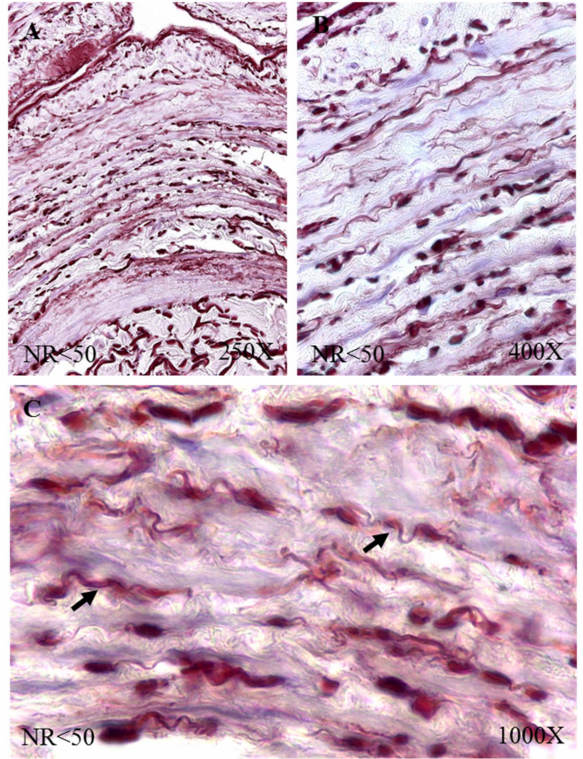
Figure 2. Images showing the elastic fibers in patients with NR < 50 ( A – C ).